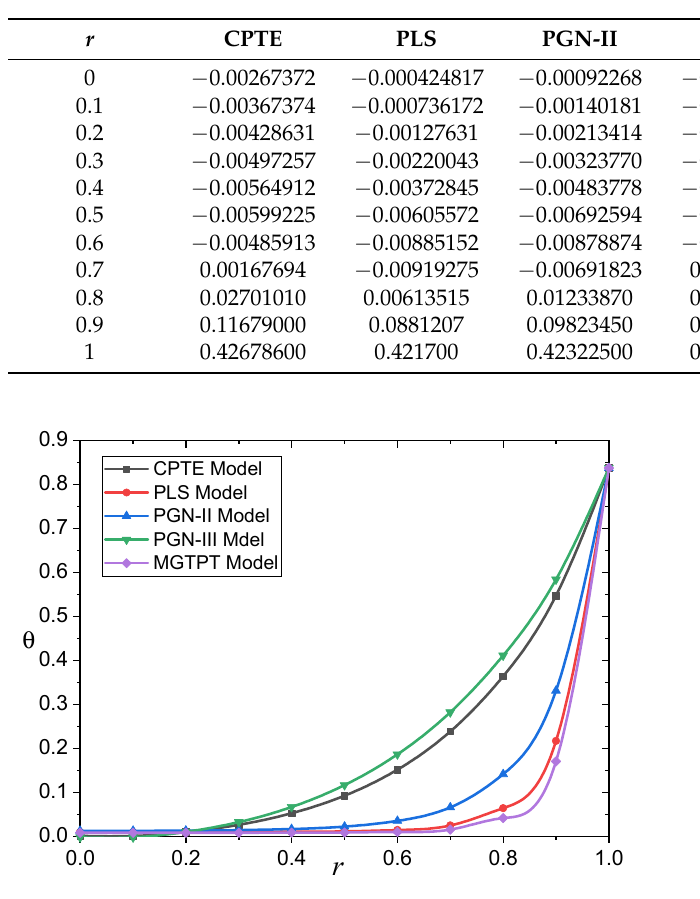
Figure 1. The temperature θ under different photothermal models.